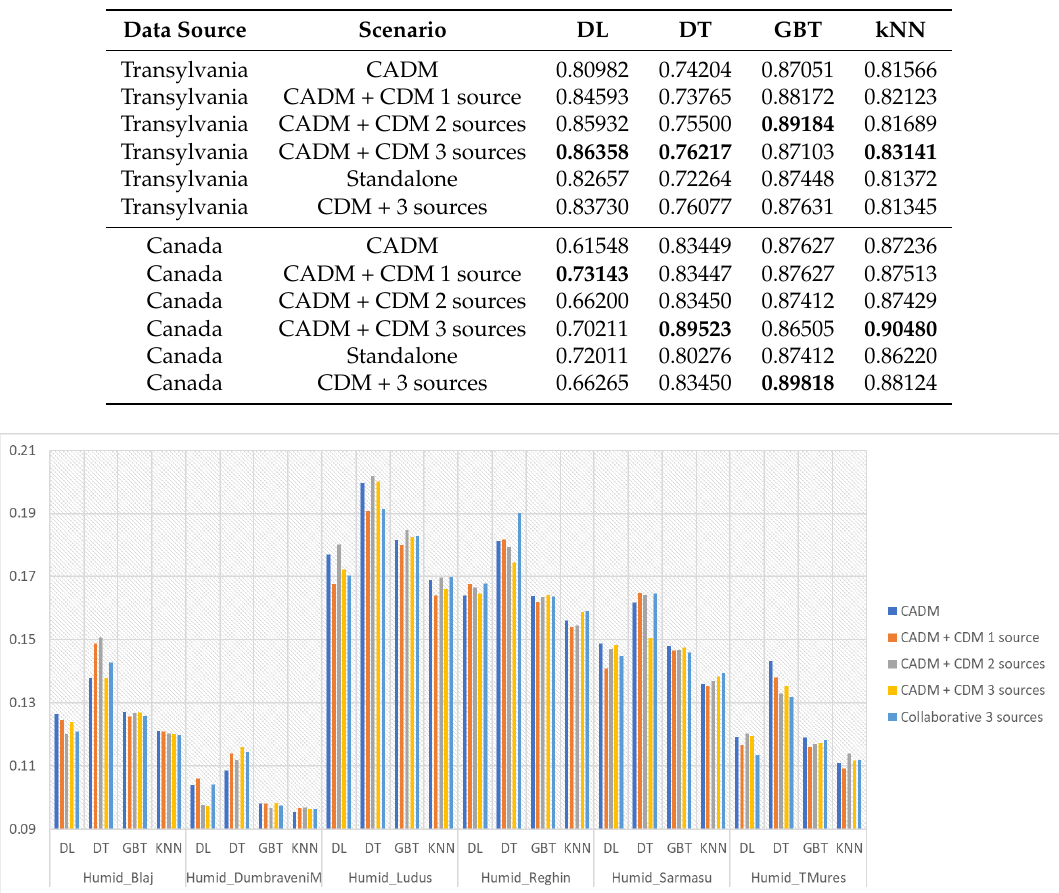
Figure 7. Relative Error (RE) overview representation per location and algorithm: location and algorithm tested ( X -axis) and the RE obtained values ( Y